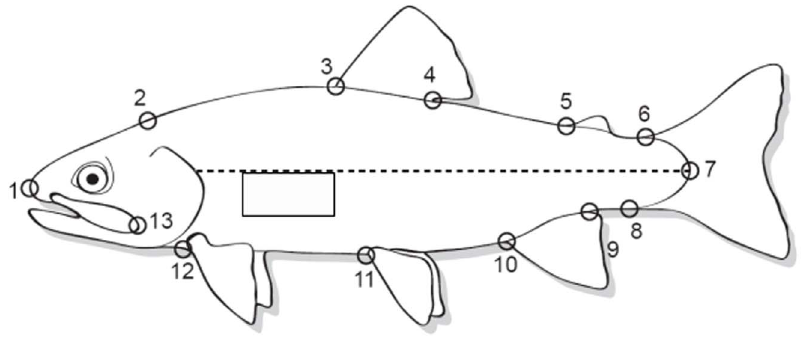
Figure 1. Location of region analyzed for skin reflectance (box) and placement of landmarks for analyzing body morphology (circles). Image modified with permission from [31] and